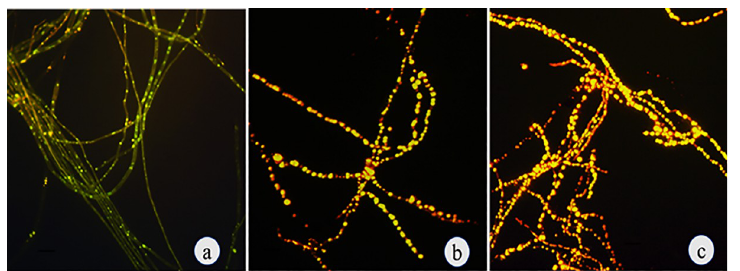
Fig 7. Fluorescent microscopy analysis of lipid bodies in SA treated mycelia of P . microspora . (a) Control. (b) 150 μ M. (c) 300 μ